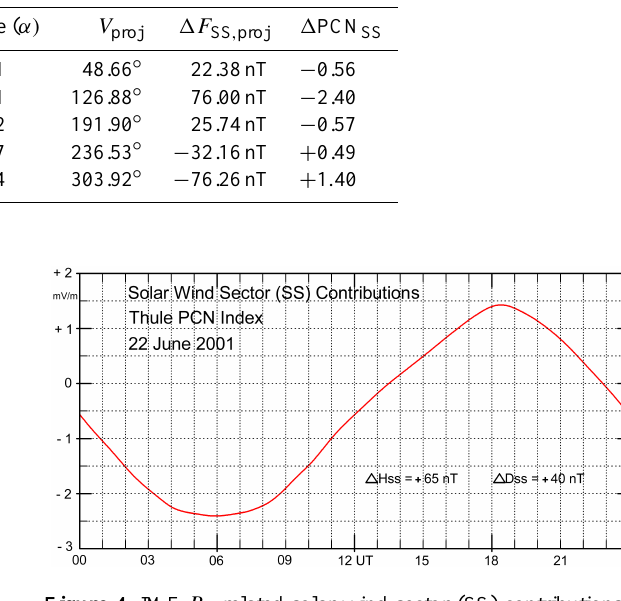
Figure 4. IMF B y -related solar wind sector (SS) contributions to the PCN index values derived according to the “effective QDC” procedure defined in JT2011 with the excursions (cid:49)H SS = 65nT defined in their Fig. 6b and (cid:49)D SS = 40nT. Index coefficients are from